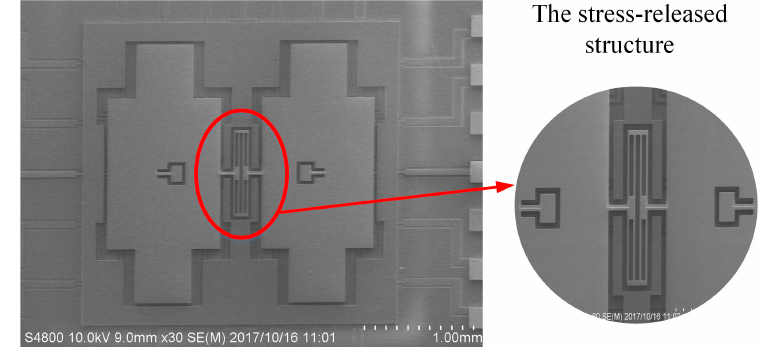
Figure 12. The electron microscope photos of the sensing structure of the BFVG.